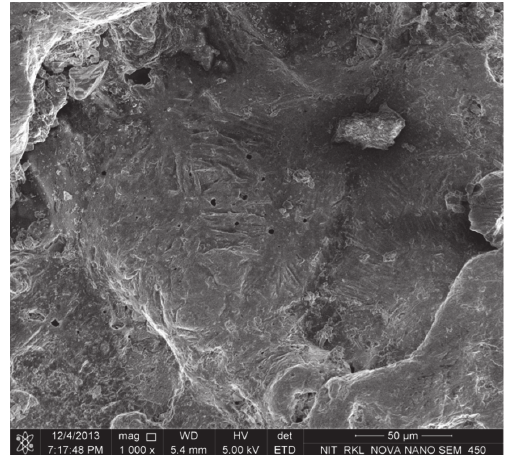
Fig. 2 . FESEM of the Al-18%SiC p MMC after